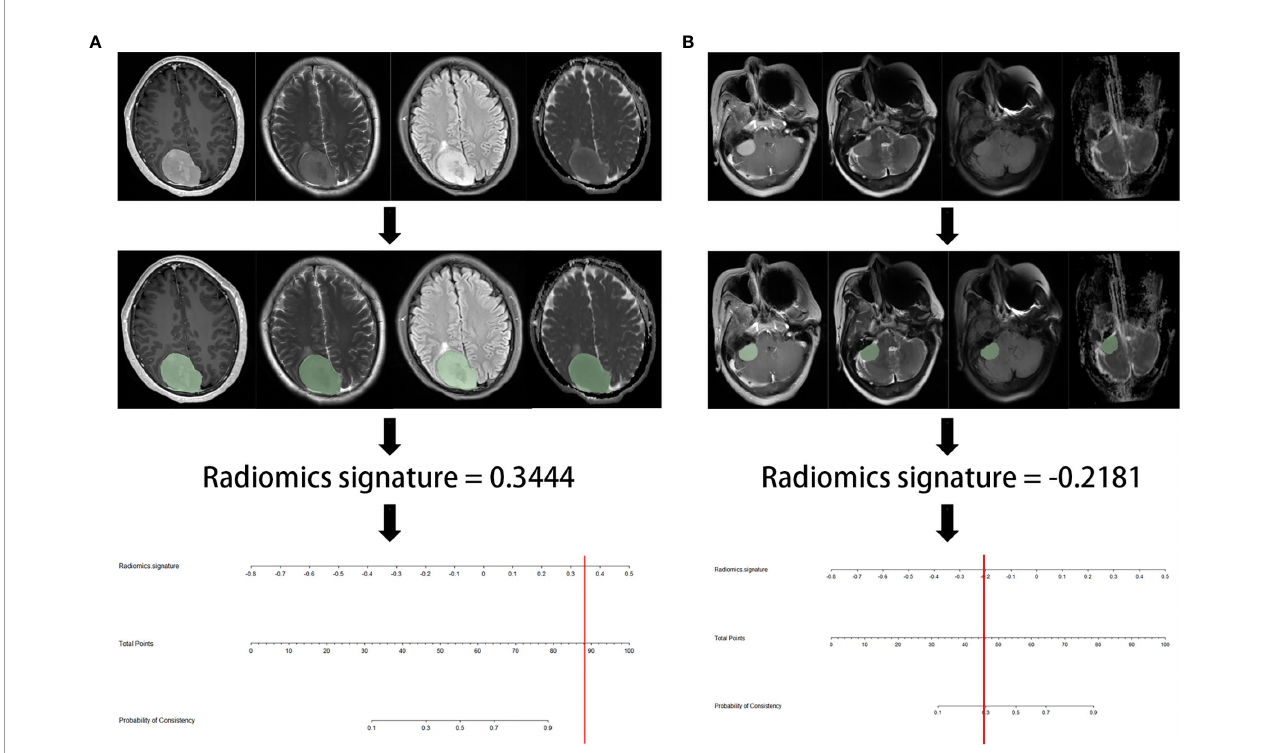
FIGURE 5 | The example fl owchart of prediction. (A) after ROI delineating, image preprocessing, the value of radiomics signature was 0.3444, which was calculated by the python script including radiomics extraction and model calculation. The result corresponded to >90% probability of a fi rm consistency. Thus, the meningioma consistency was predicted to be fi rm, which was con fi rmed in surgery. (B) the radiomics signature was -0.2181, which corresponding to a 30% probability of a fi rm consistency. Thus, the meningioma consistency was predicted to be soft, which was con fi rmed